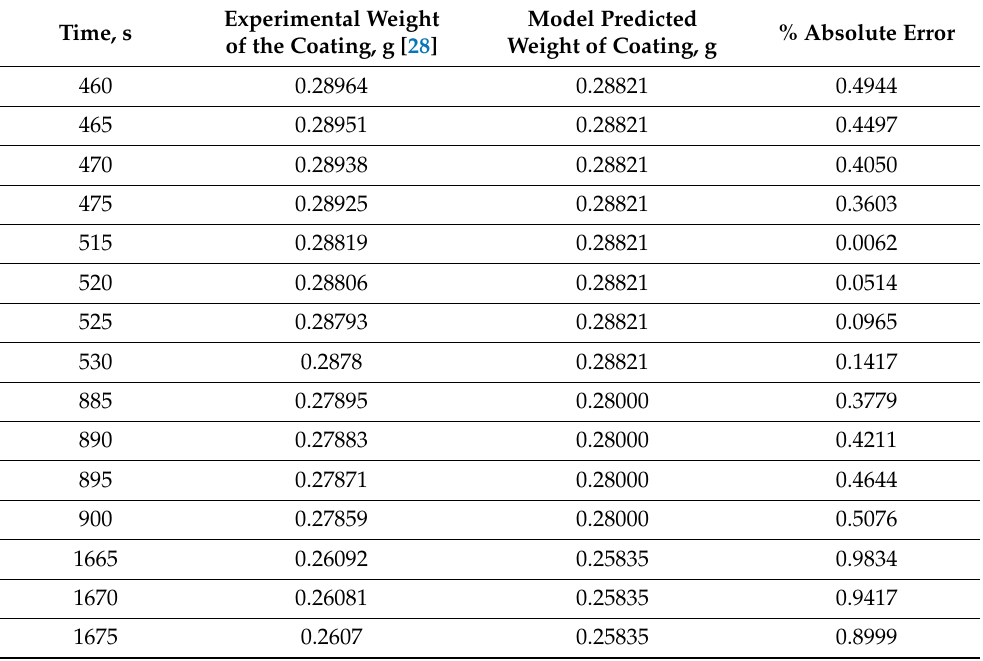
Table 1. Sample error between predicted and experimental values for 2021 µ m initial coating thickness with poly(styrene), p -xylene, and TPP contents of 4.95%, 95.05%, and 0%, respectively.